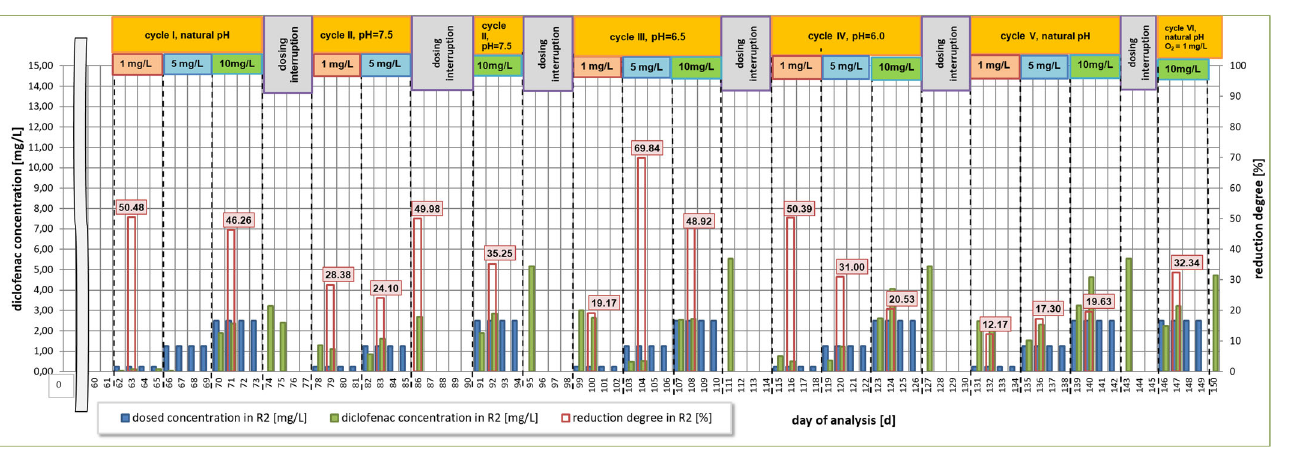
Figure 2. Degree of diclofenac reduction after 1 day from dosing a specific dose of the drug in the R2 bioreactor in all analyzed research series .